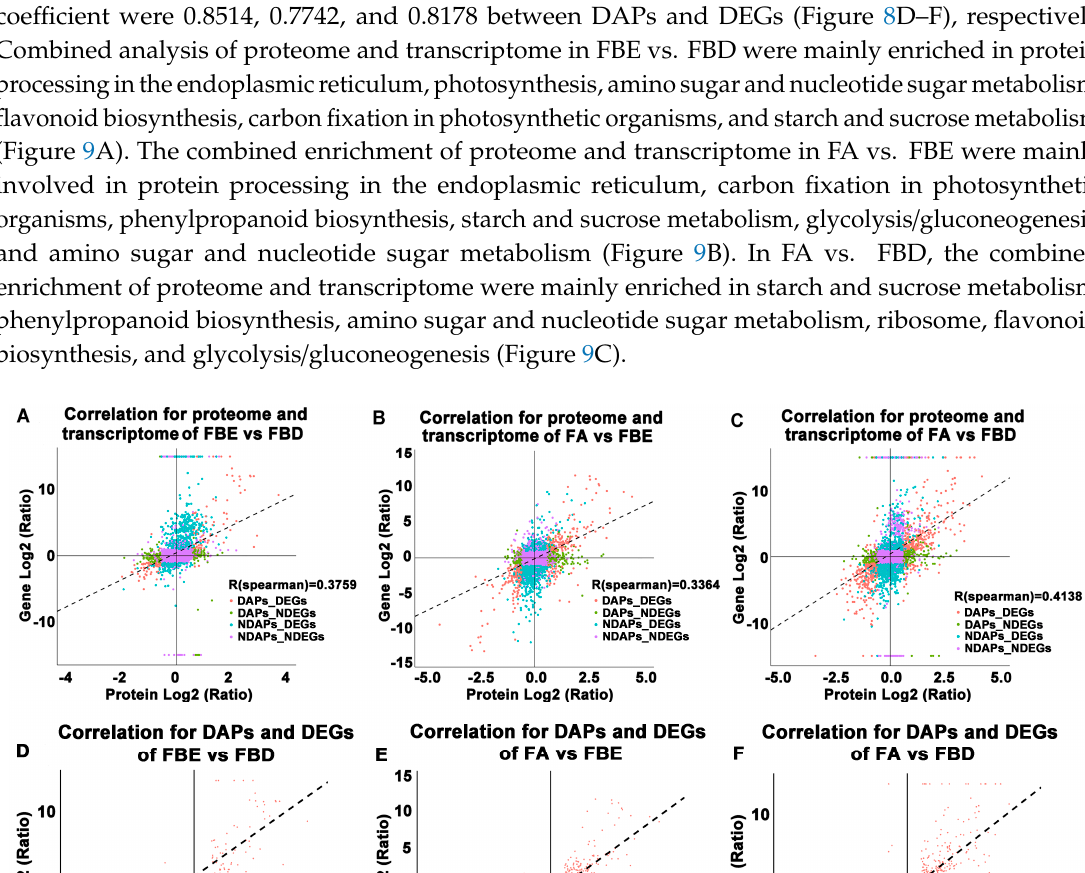
Figure 9. Combined enrichment of proteome and transcriptome in FBE vs. FBD, FA vs. FBE, and FA vs. FBD. ( A ) Combined enrichment of proteome and transcriptome in FBE vs. FBD. ( B ) Combined enrichment of proteome and transcriptome in FA vs. FBE. ( C ) Combined enrichment of proteome and transcriptome in FA vs. FBD. Starch and sucrose metabolism is marked by red arrows. 2.8. Validation of the Expression Levels of Several Key Flower Development-related Genes